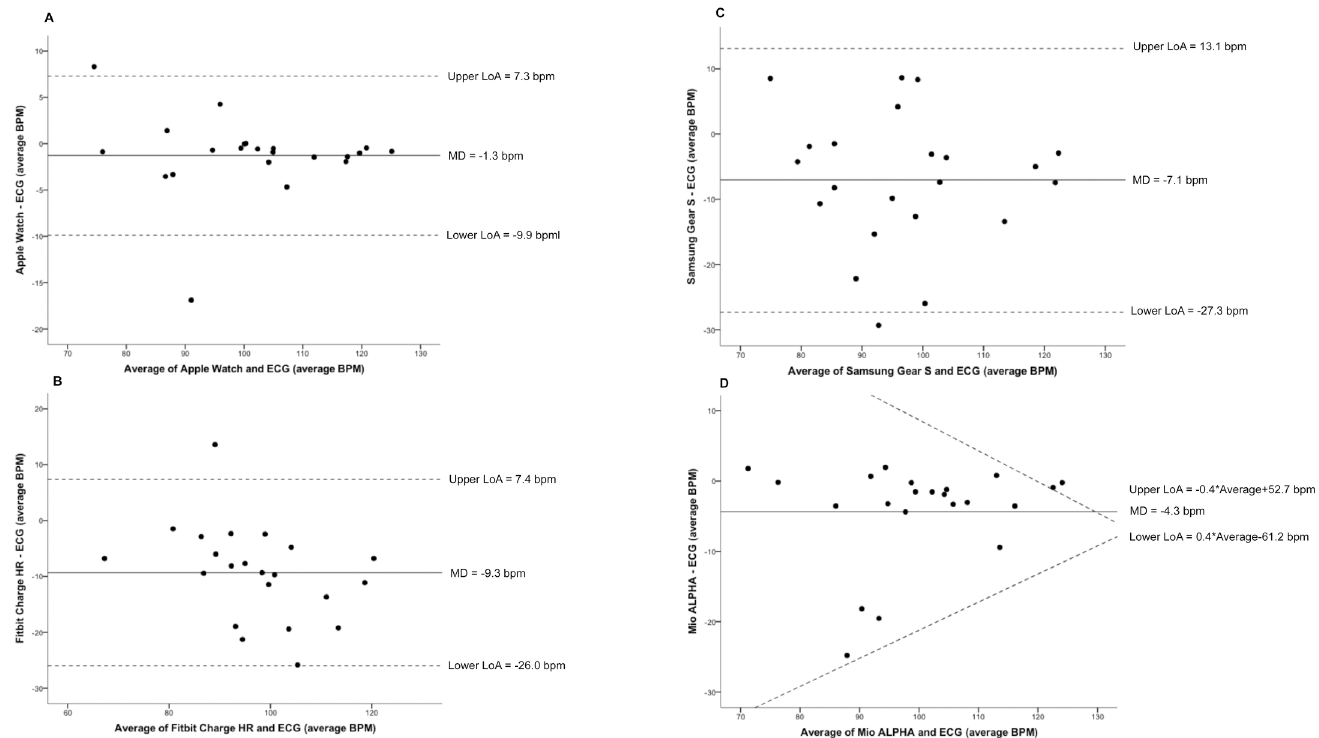
Fig 3. Bland-Altman plots for device [(A) Apple Watch; N = 22, (B) Fitbit Charge HR; N = 22, (C) Samsung Gear S; N = 22, (D) Mio ALPHA; N = 22] and electrocardiography (reference) average heart rate (bpm). The solid line represents the mean difference (bpm) between the two measures and the dashed lines are the 95% limits of agreement (bpm). Notes : bpm = beats per minute, LoA = limits of agreement, MD = mean difference.